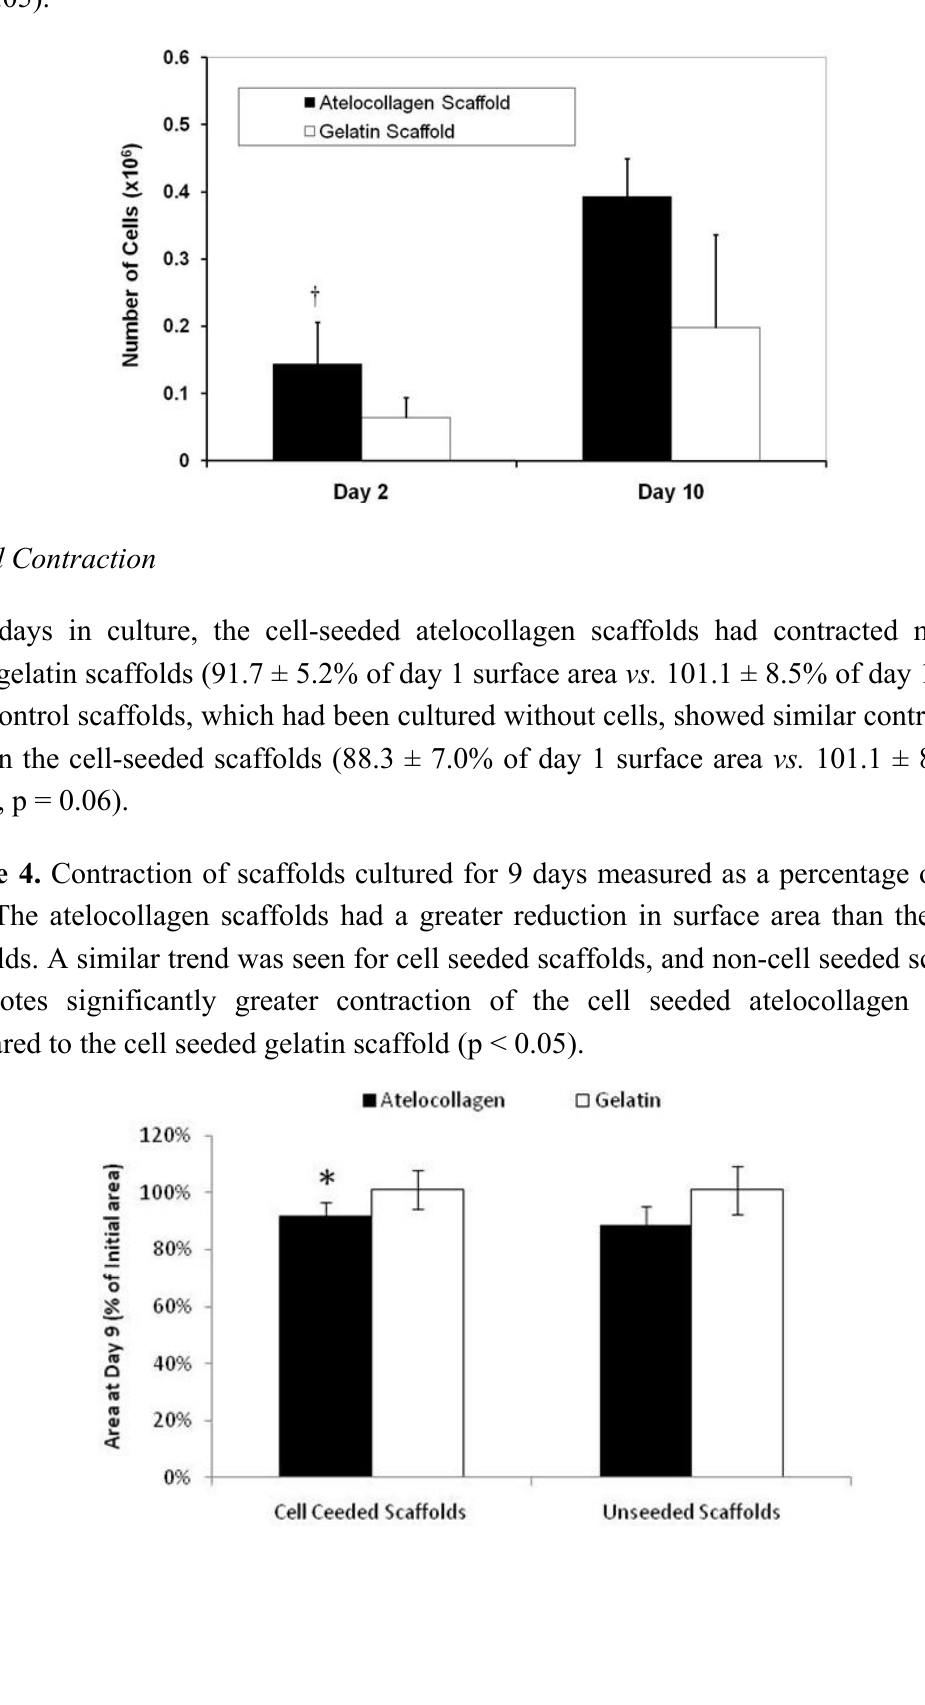
Figure 3. Cell proliferation within atelocollagen and gelatin scaffolds at 2 and 10 days after seeding as measured by the MTT assay. Cell numbers in both types of scaffolds increased between 2 and 10 days. Atelocollagen scaffolds had a higher cell concentration at 2 days. † denotes significantly higher cell number in the atelocollagen scaffolds at 2 days (p < 0.05).